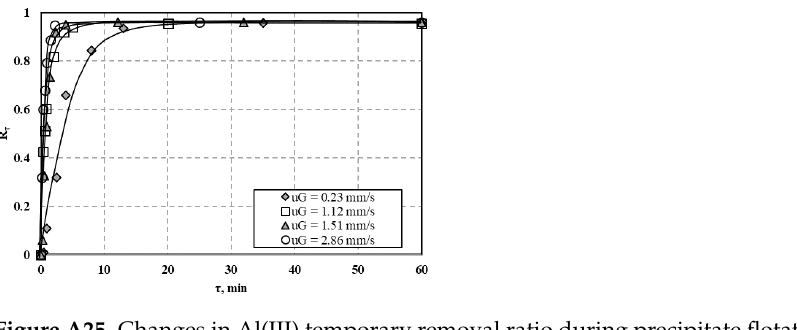
Figure A25. Changes in Al(III) temporary removal ratio during precipitate flotation from solution containing Al(III), Cu(II), and Zn(II) mixture—effect of air velocity (c 0 = 2 mmol dm − 3 , pH = 8.7, c SDS = 0.187 mmol dm − 3 ).